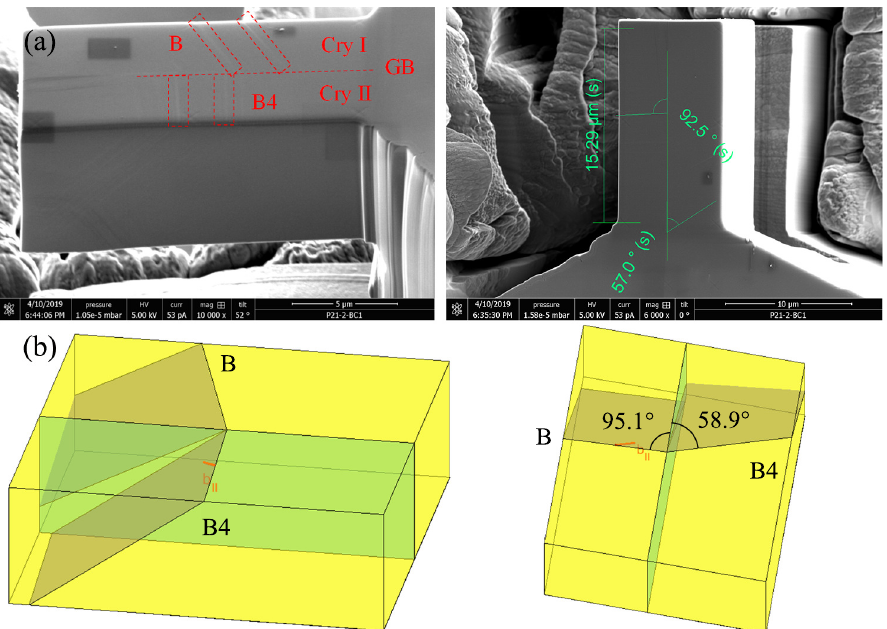
Figure 3. ( a ) crystallographic analysis of slip lines from SEM picture for the Ni sample; ( b ) theoretical analysis of slip systems based on microstructural data (see Table 1).